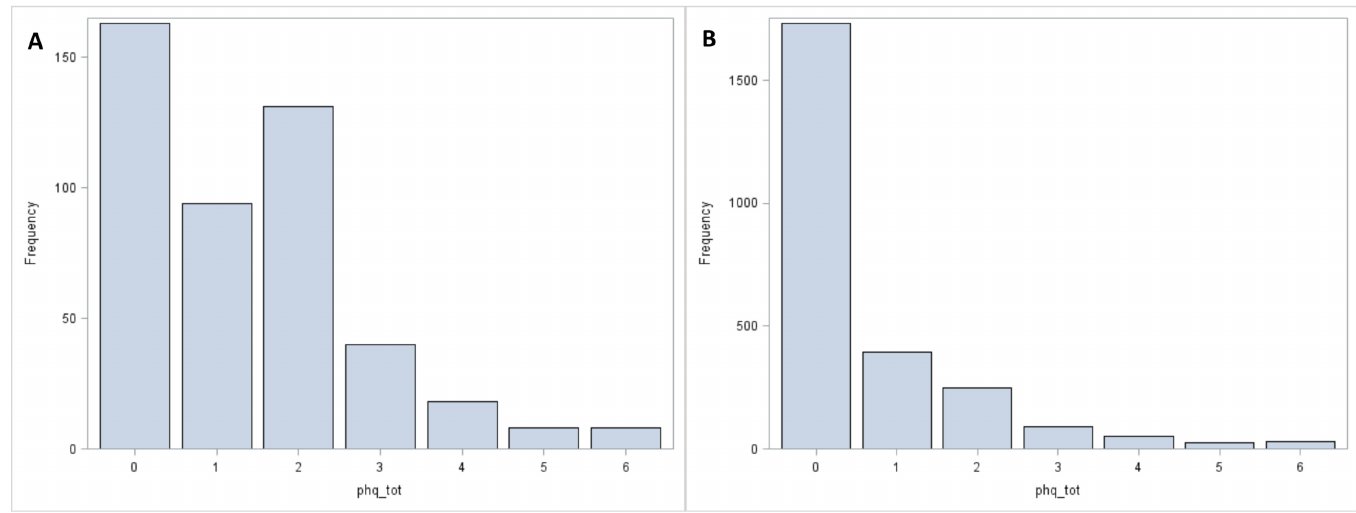
Fig 1. A. Distribution of PHQ-2 scores in study population. B. Distribution of PHQ-2 scores in NHANES population (ages 18 – 45 years).